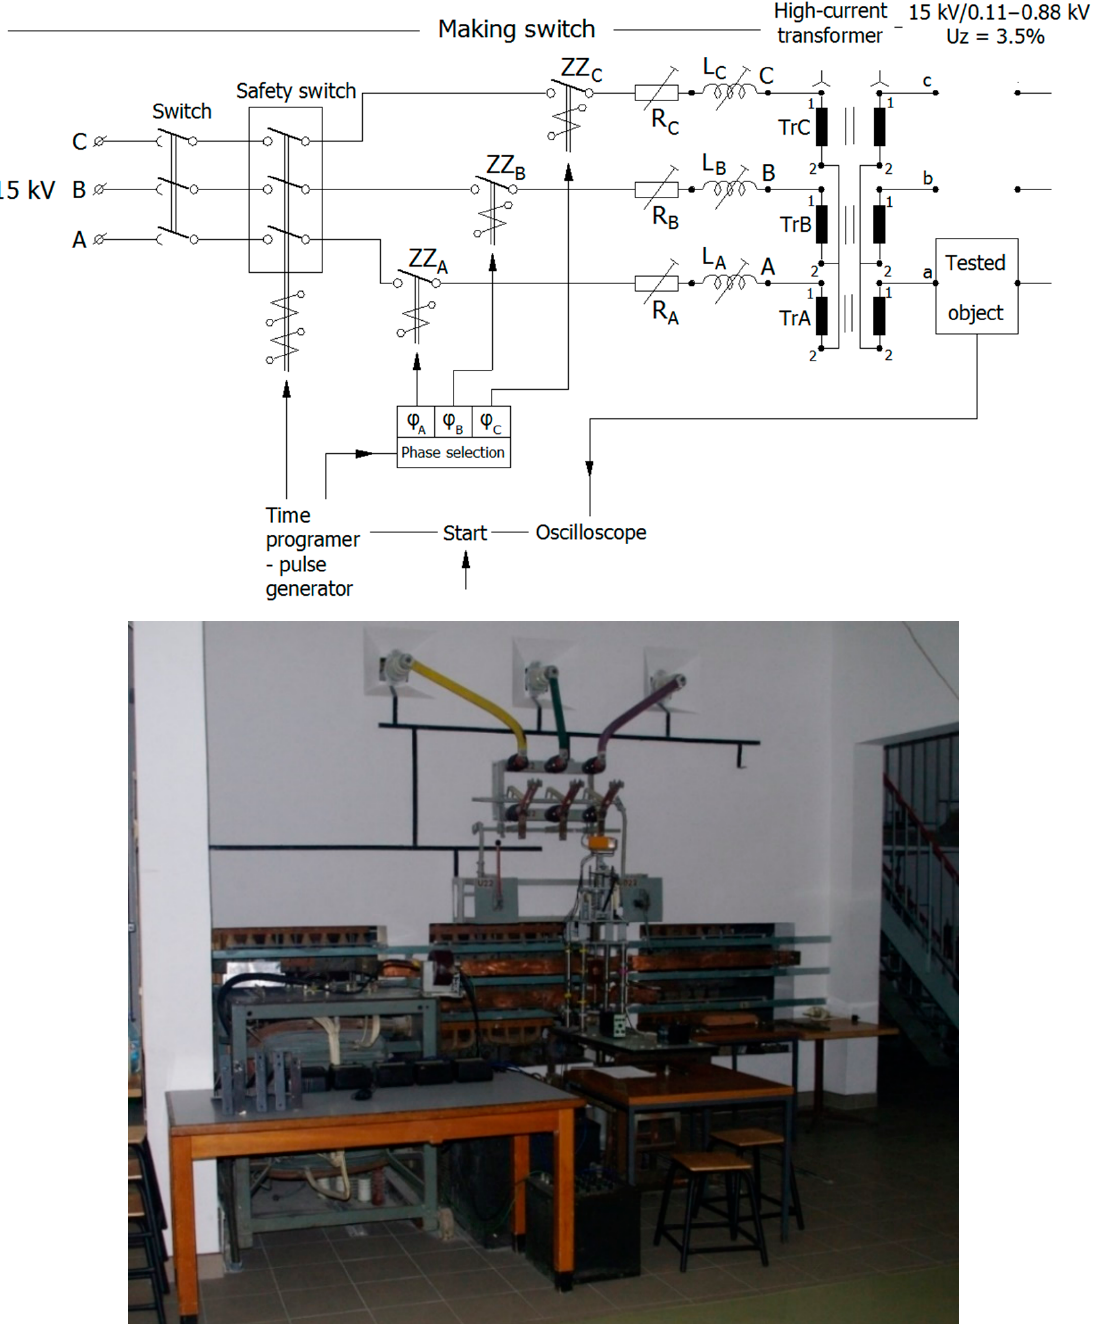
Figure 13. Short-circuit system used for laboratory tests. The Short-Circuit Laboratory, Electrical Faculty, Warsaw University of Technology.